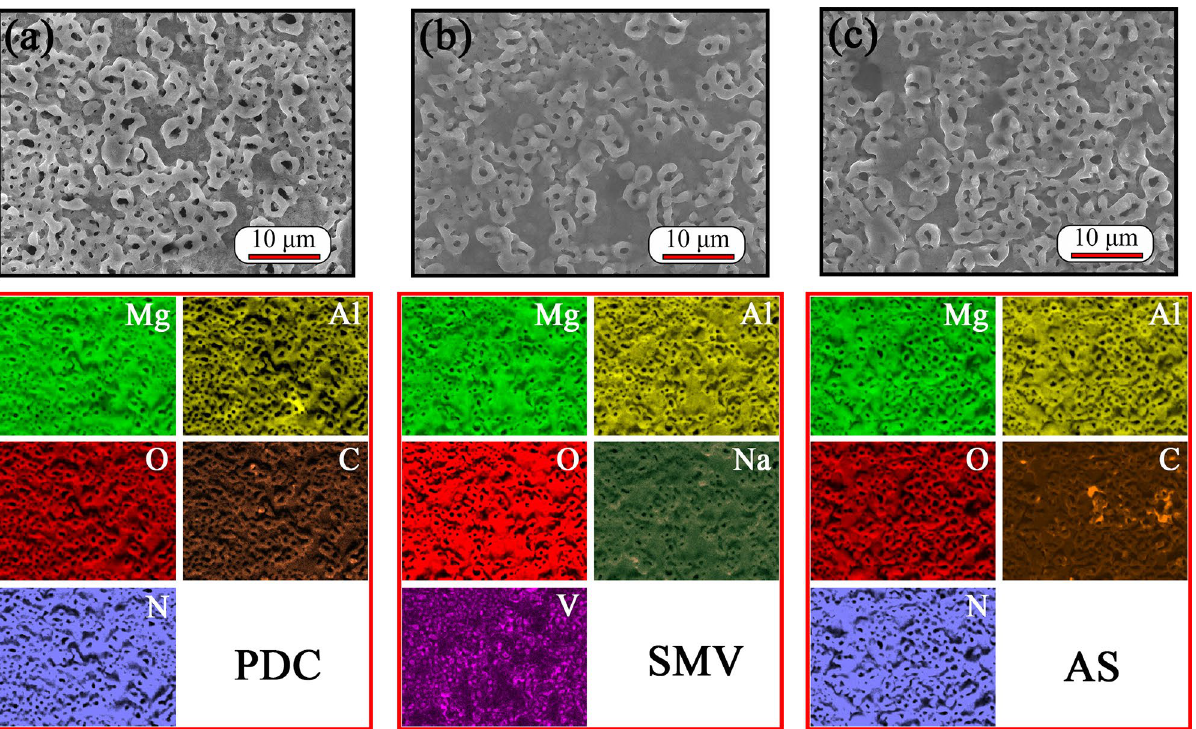
Figure 2. SEM surface morphologies and corresponding EDS mappings of ( a ) PDC, ( b ) SMV and ( c ) AS